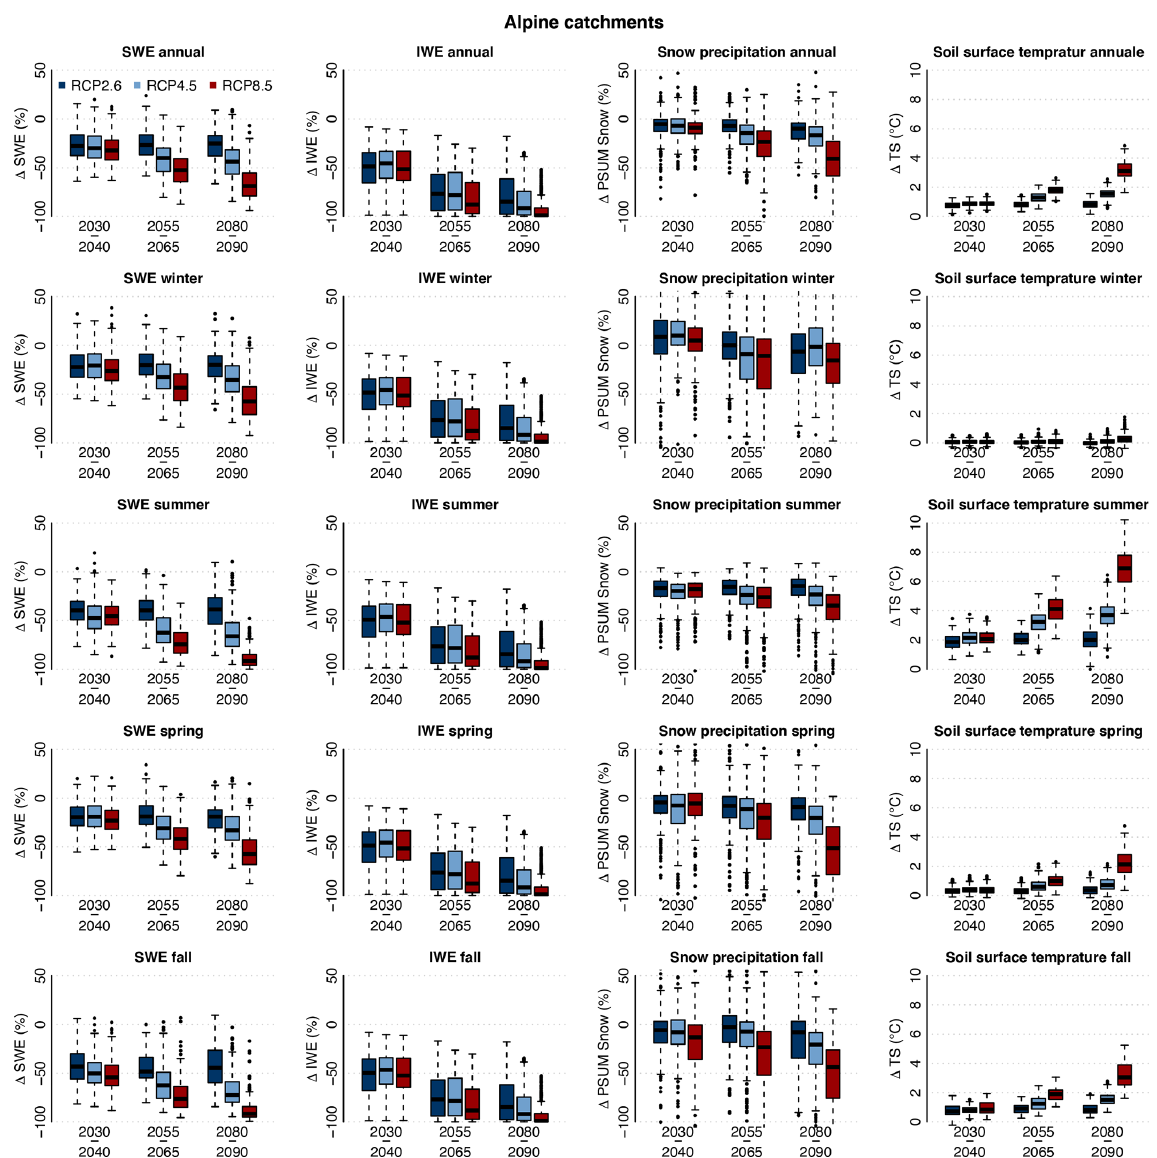
Figure 6. Changes in snow water equivalent in the catchments ( (cid:49) SWE), in ice water equivalent (mass of glacier ice and snow in glacier pixels) in the catchments ( (cid:49) IWE), in solid precipitation ( (cid:49) PSUM snow), and in soil surface temperature ( (cid:49) TS), from left to right column, over the periods 2030–2040, 2055–2065, and 2080–2090 and for the three RCP scenarios compared to the reference period 1990–2000, averaged over all considered Alpine catchments. Row 1 shows the annual change, row 2 the winter seasonal change, row 3 the summer seasonal change, row 4 the spring seasonal change, and row 5 the autumn seasonal